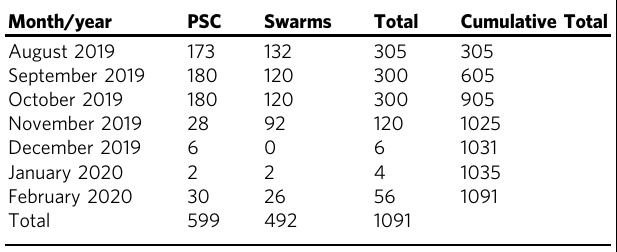
Table 4 Monthly and cumulative numbers of A. gambiae s.l. individuals sampled and analysed by PCR (Polymerase Chain Reaction) for Anopheles coluzzii Dominant Sterile Male (Ac(DSM)2) transgene